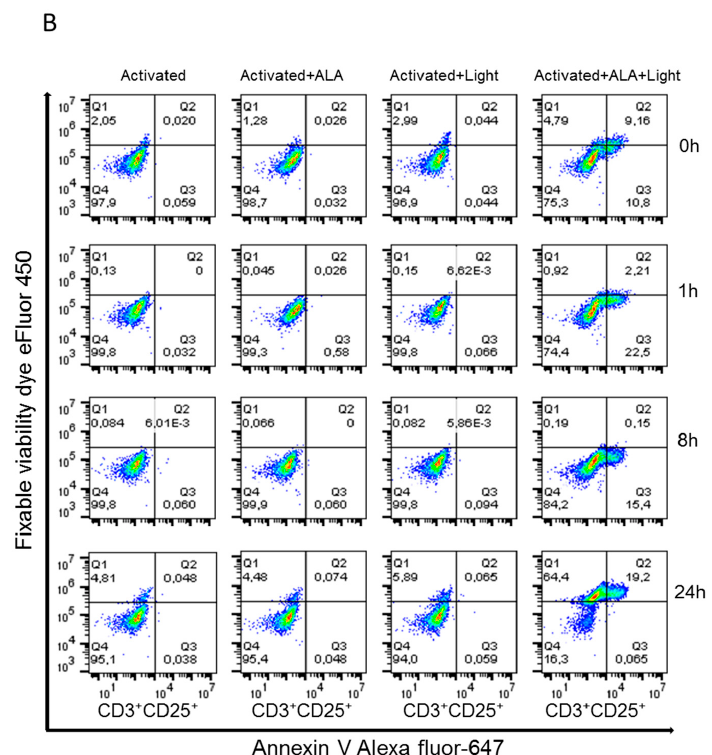
Figure 3. ALA-PDT mediated apoptosis and necrosis of CD3 + CD25 + T cells in PBMCs. Healthy